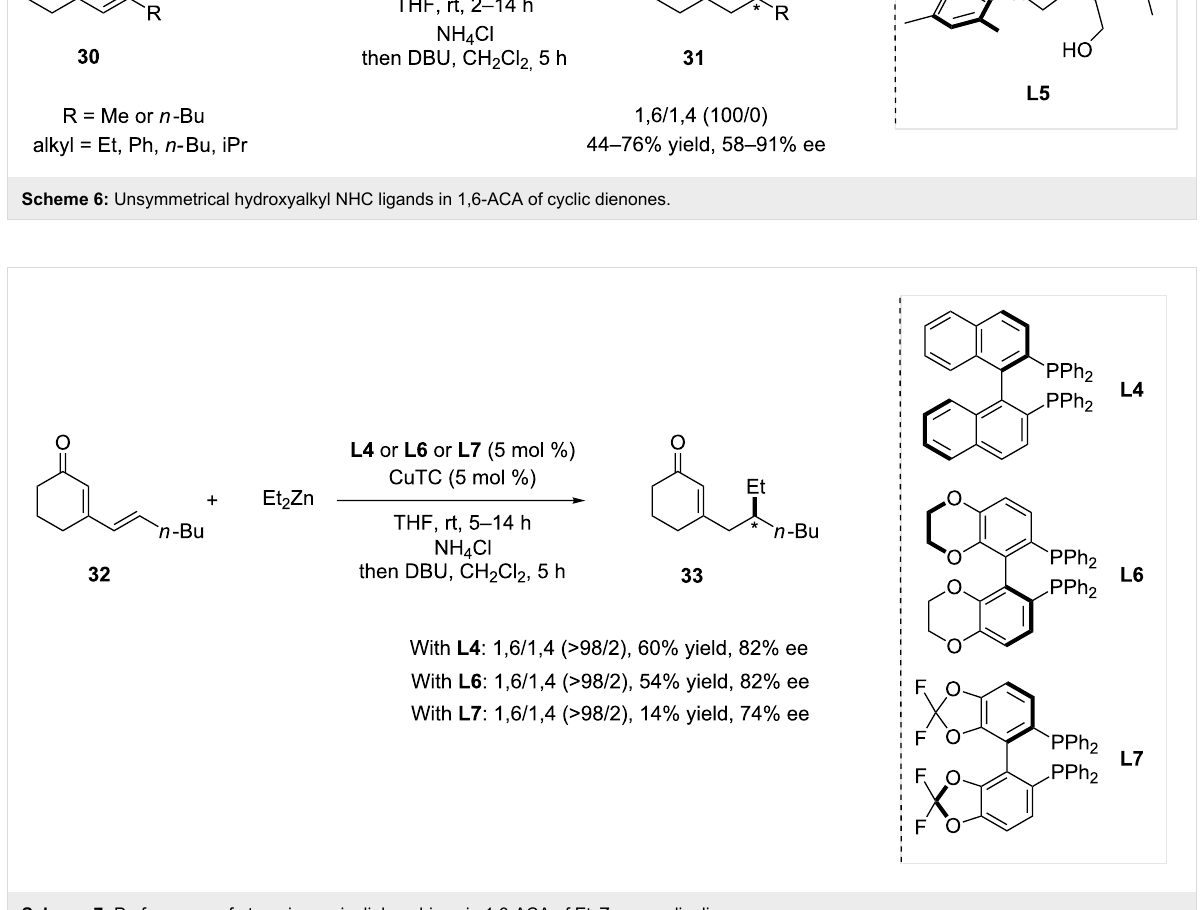
Scheme 7: Performance of atropoisomeric diphosphines in 1,6-ACA of Et 2 Zn on cyclic